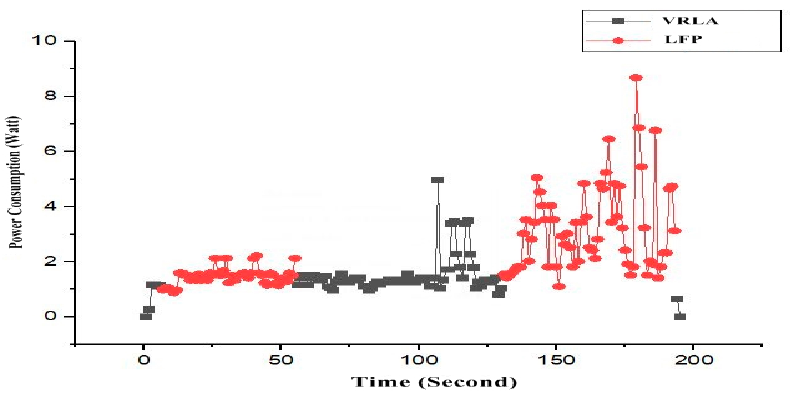
Figure 21. Dual battery power consumption of VRLA and LFP graph. Testing of switching waves was carried out using Oscilloscope Hantek 6022BE Version 1.0.6 through the Hantek software on a laptop by looking at the PWM waves from Arduino’s high output and switching on the MOSFET pin source. As seen in Figure 22, a wave is formed when the PWM input value is 80% on the high output side. The wave has a time/div of 2 ms and 5 V volt/div. The period value of the PWM wave is 6 ms and the amplitude value is 20 V.